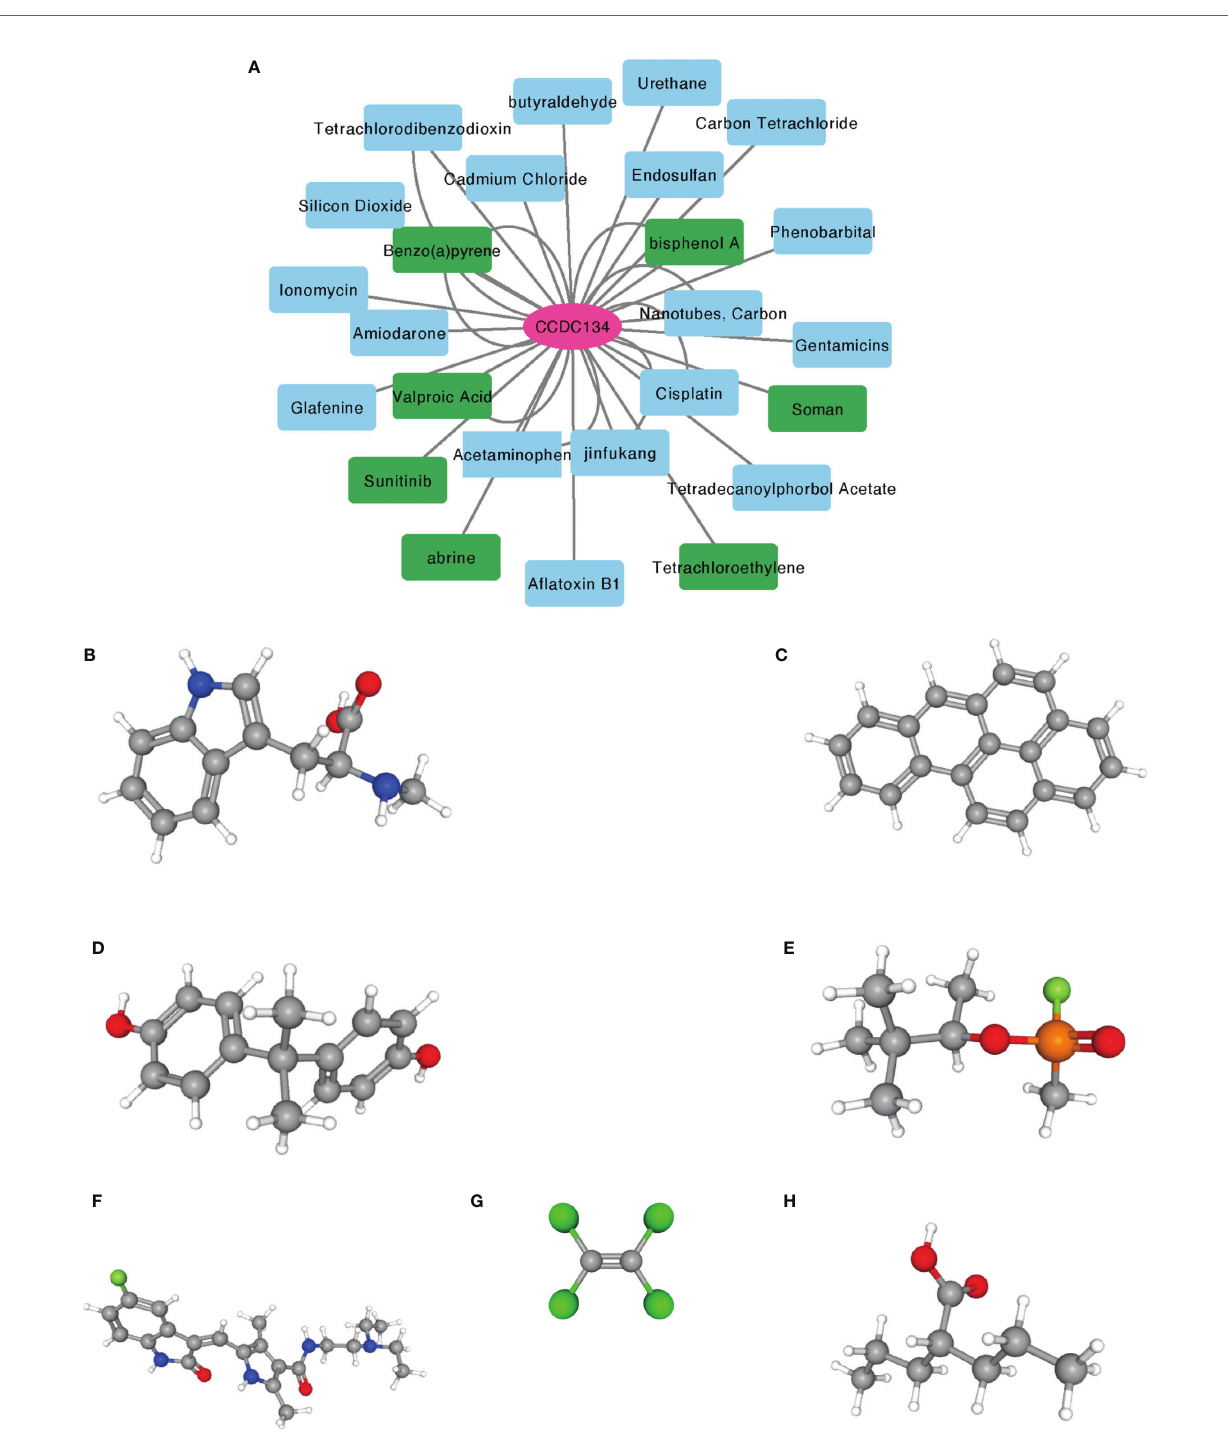
FIGURE 9 | Prediction of potential drug and molecular structure affecting CCDC134. (A) CTD database predicts potential drugs that affect CCDC134, with green representing drug molecules that inhibit CCDC134. (B – H) PubChem database predicts the molecular structures of seven targeted drugs. (B) abrine, (C) Benzo(A) Pyrene, (D) bisphenol A, (E) Soman, (F) Sunitinib, (G) Tetrachloroethylene, (H) Valproic